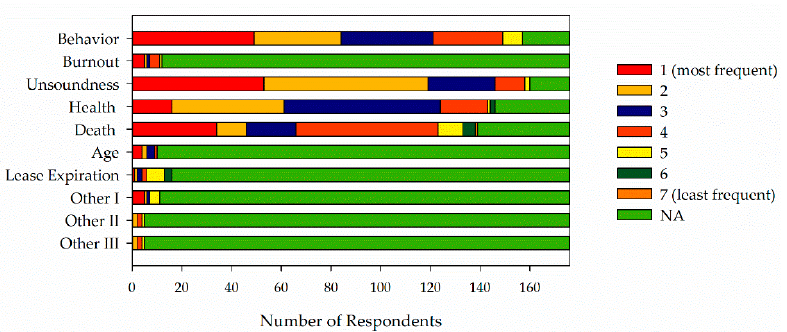
Figure 8. Reasons for retiring horses and ponies. Reasons for retirement were ranked consecutively from 1 (most frequent) to least frequent. Respondents could choose NA if the reason was not applicable in their situation.